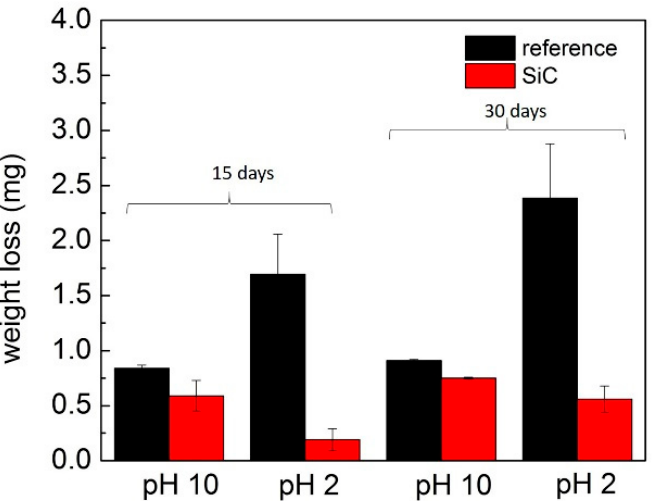
Figure 1. The weight loss of non-coated (ref) and silicon carbide (SiC)-coated disks constantly immersed in pH 10 and pH 2 for 15 and 30 days.